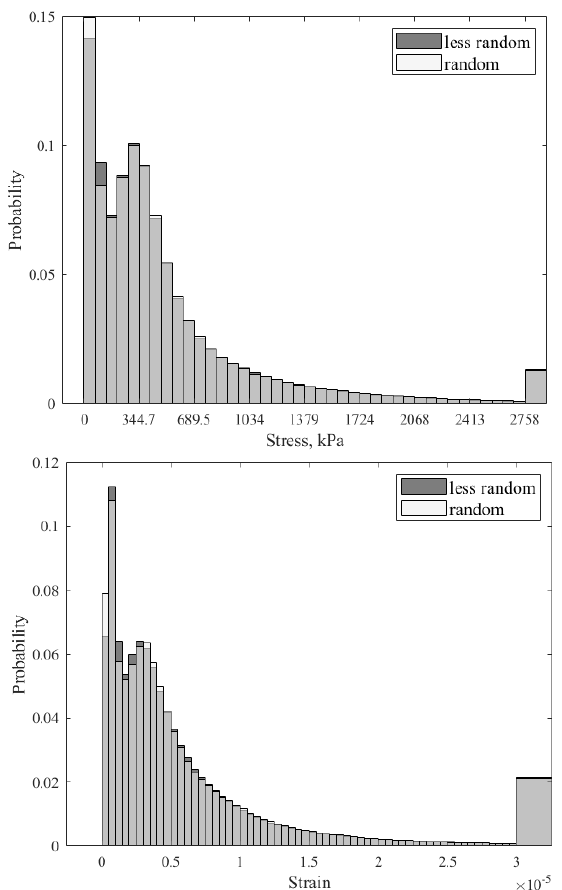
Figure 3. Combined histogram of element ‐ wise strain and Von Misses stress magnitude for all 6 notched bending specimens with randomly arranged aggregate and all 6 notched bending specimens with less randomly arranged aggregate.